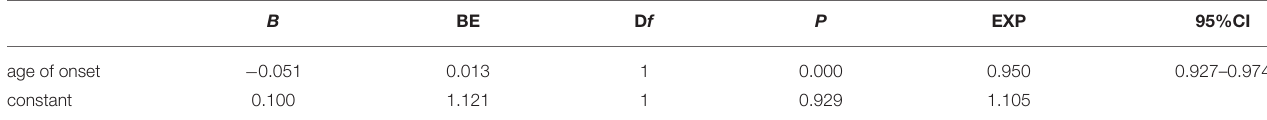
TABLE 2 | Logistic regression of clinical characteristics between patients with MDD and BD.